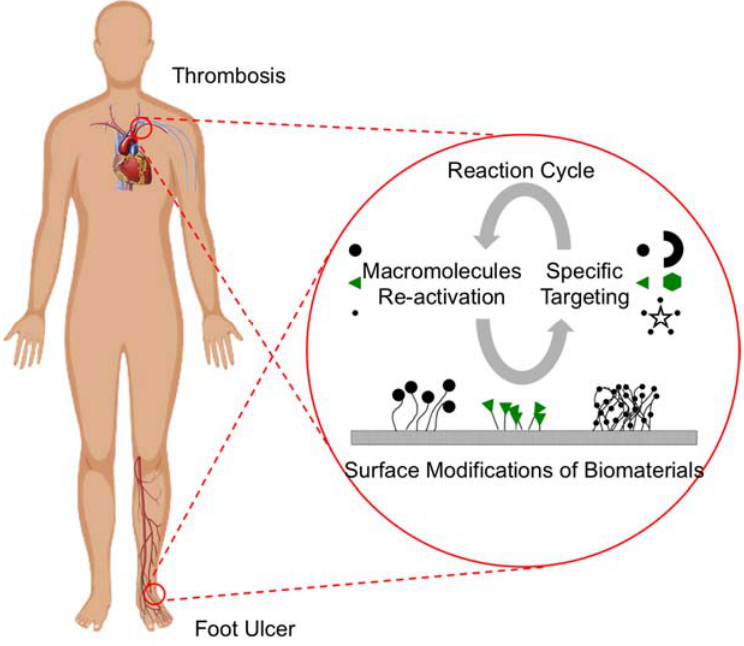
Figure 7. A schematic diagram of proposed future direction for biomedical devices with surface attachments of macromolecules. The macromolecules contain specific binding with target molecules and/or cells, and the macromolecules become activated again in the body allowing reattachment to the specific sites for the next functional cycle.